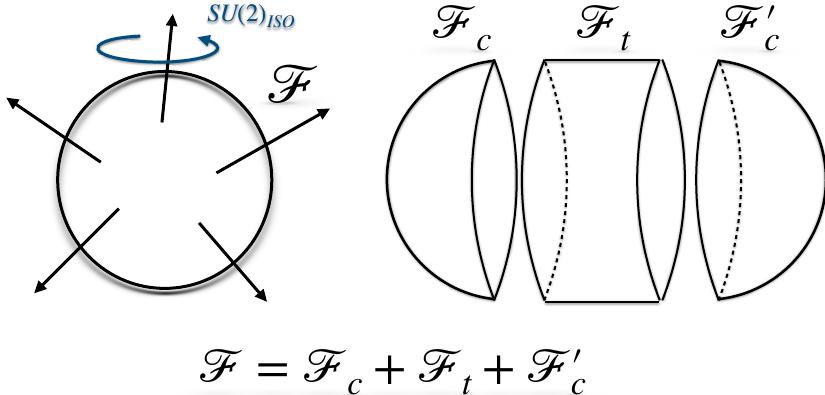
Figure 1: The theory corresponding to a sphere with flux can be constructed by combining together theories corresponding to one punctured spheres (caps) and two punctured spheres (tubes). The flux associated to the resulting theory is the sum of fluxes of the components. In particular different ways to split the flux into com- ponents might lead to different looking Lagrangians which have to be dual to each other. Moreover different values of flux related by the Weyl group of the 6d symmetry lead again to equivalent, IR dual, theories. The flux of the components can break the symmetry of the 6d theory to smaller sub-group than the combined theory, leading to Lagrangians with emergent symmetry in the IR. The compactification surface has an SU ( 2 ) isometry symmetry which becomes a global symmetry of the 4d ISO